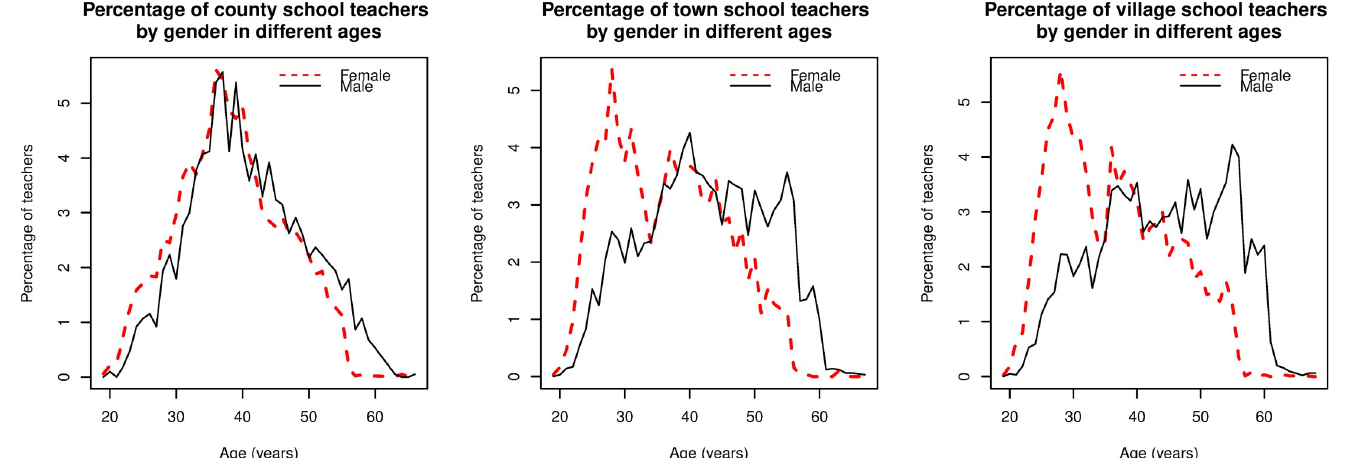
Fig 3. Percentage of male and female teachers in terms of age in county, town, and village schools.